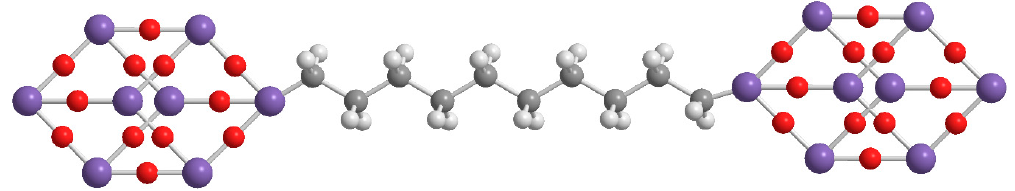
Figure 3. Molecular structure of aliphatic dumbbell shaped POSS.